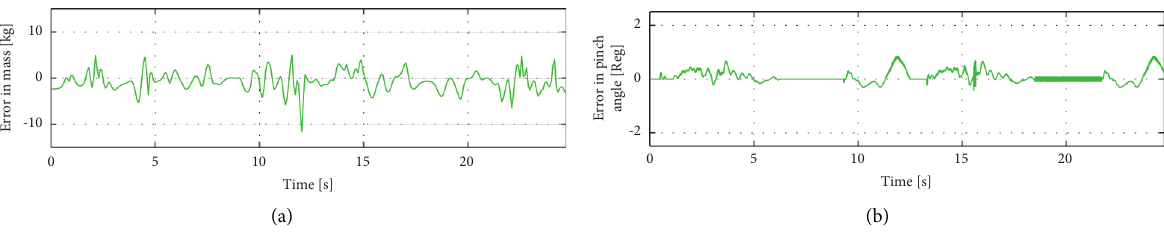
Figure 9: Estimation errors by the improved BVCIE at 40km/h on asphalt road. (a) Estimation error in mass. (b) Estimation error in pitch angle.